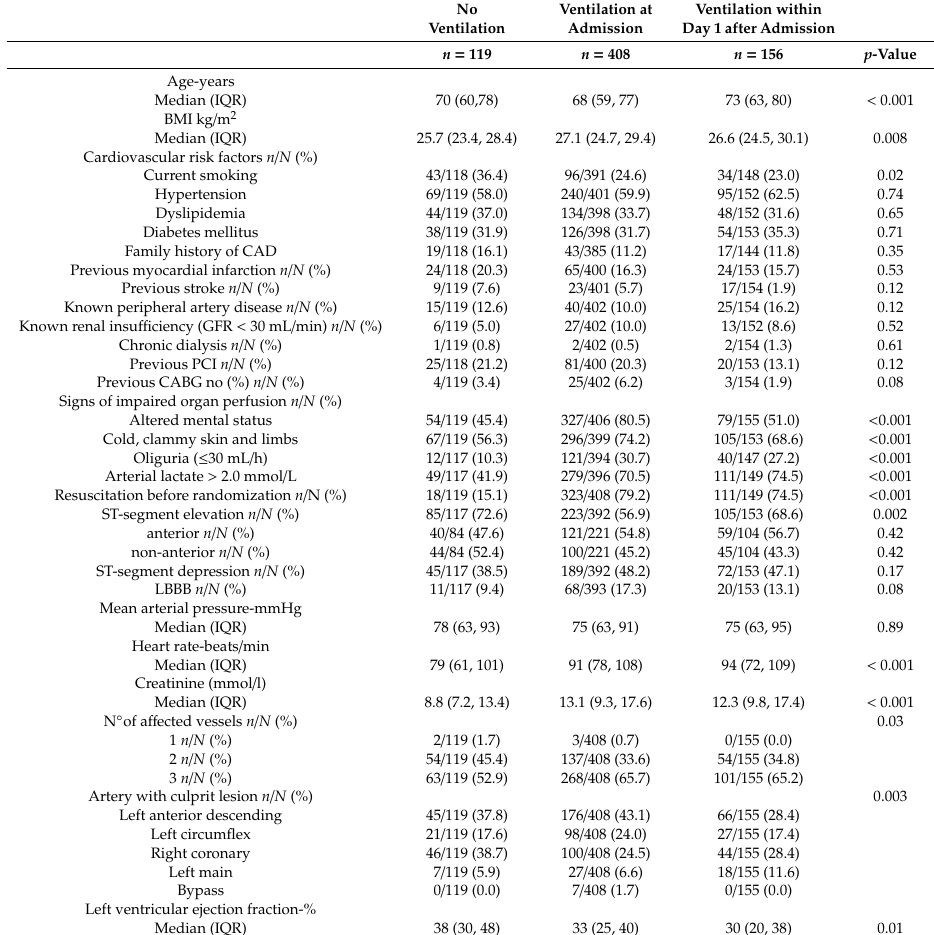
Table 1. Baseline characteristics.